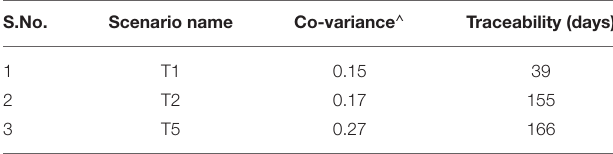
TABLE 2 | Summary of temporally dynamic scenarios investigated.